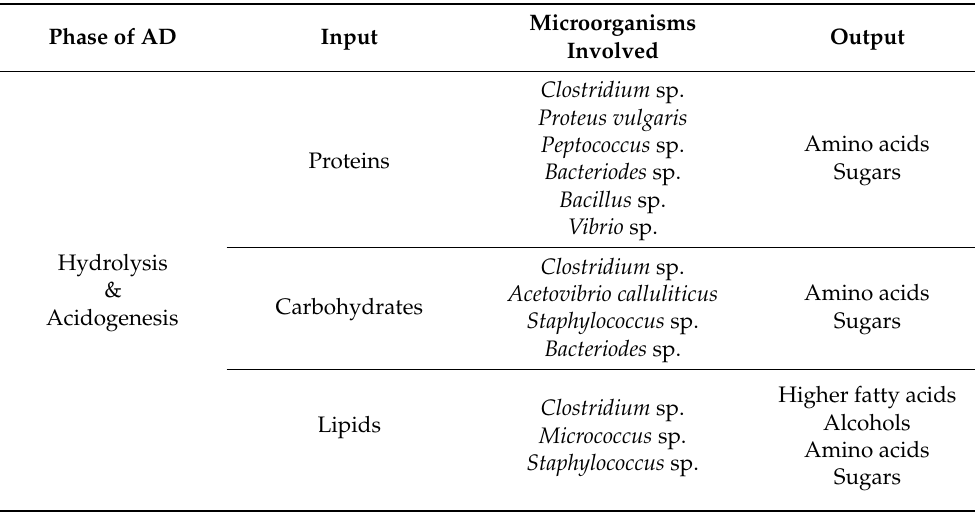
Table 1. Breakdown of organic polymers and microorganisms involved (adapted from [47]).